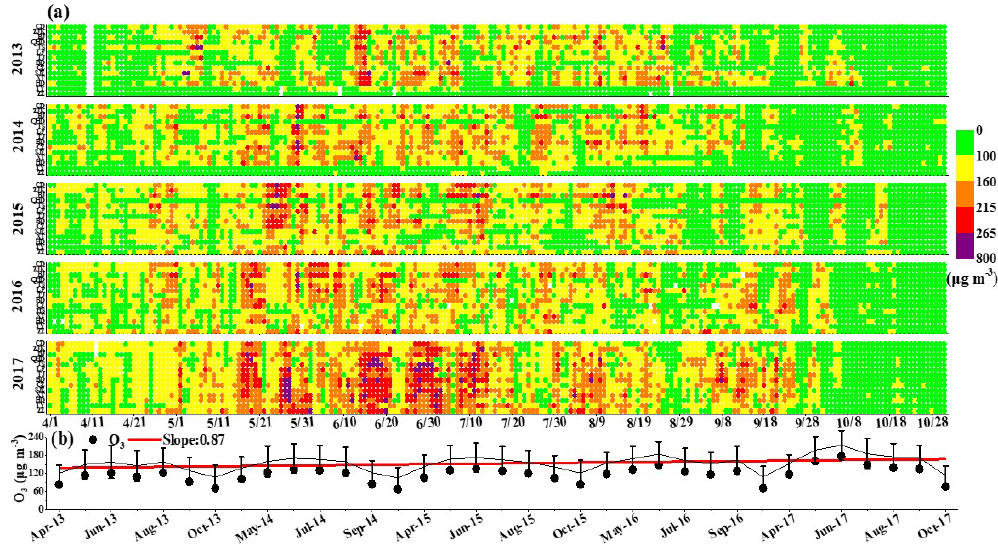
Figure 2. Time series of daily MDA8 O 3 concentrations in 14 cities (north to south) (a) , together with monthly averaged concentrations and standard deviations (b) , from April to October from 2013 to 2017. Five ranks represent different air-quality levels, including excellent (green spots), good (yellow), lightly polluted (orange), moderately polluted (red) and heavily polluted (purple) days with cutoff concentrations of 100, 160, 215 and 265µgm − 3 , respectively. The fit line (red line) in (b) represents the increasing trend of monthly mean MDA8 O 3 .